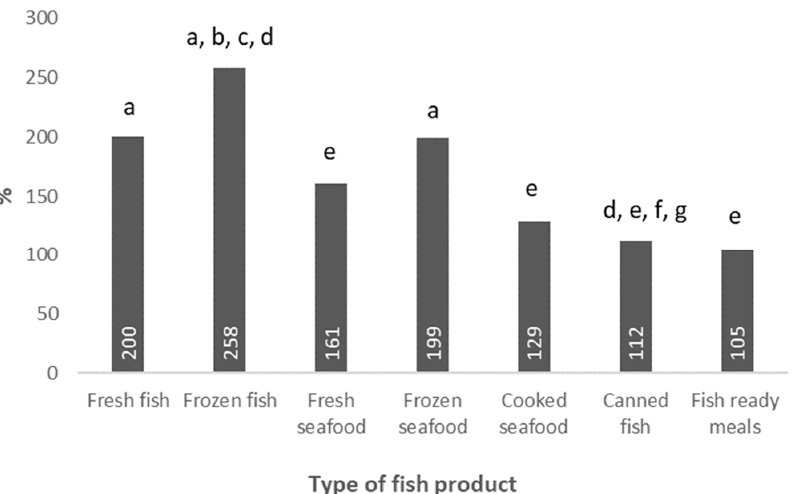
Figure 4. Relative increment in total purchases of fish, seafood, and fish products in Spain from 2019 to 2020, during the period March to June, according to type of fish product. a, Significant differences ( p < 0.005) compared to canned fish; b, Significant differences ( p < 0.005) compared to fresh seafood; c, Significant differences ( p < 0.005) compared to cooked seafood; d, Significant differences ( p < 0.005) compared to fish based ready-to-eat meals; e, Significant differences ( p < 0.005) compared to frozen fish; f, Significant differences ( p < 0.005) compared to fresh fish; g, Significant differences ( p < 0.005) compared to frozen seafood.